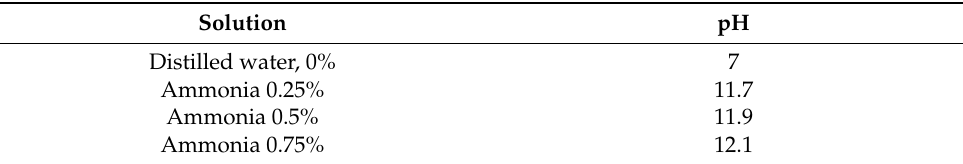
Table 1. pH values of the solutions.